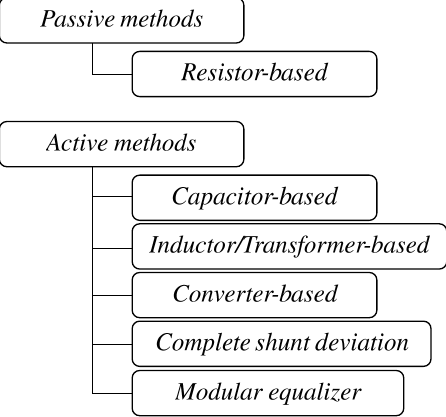
Figure 1. Classification of the Battery Equalizer Circuits